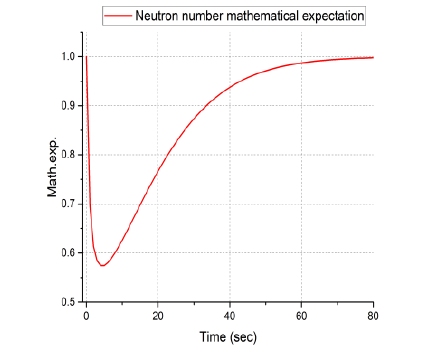
Fig. 1. The fundamental curve of neutron and breeding medium